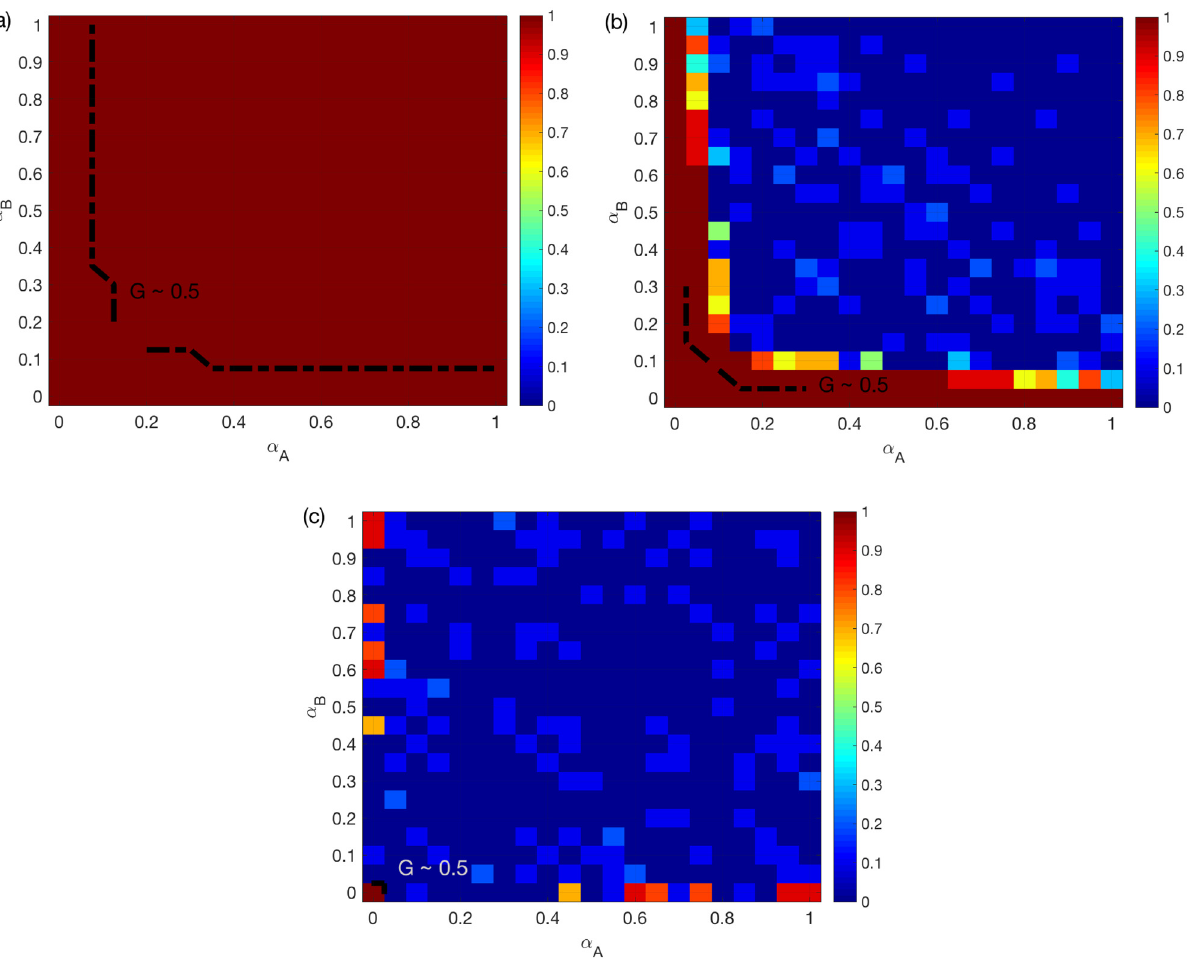
Fig 4. Best choice of overlap ratio r for two ER networks. (a) OR rule. (b) SUM rule. (c) AND rule. N = 500, k A = k B = 6, averaged over M = 90 realizations.The color for certain α A and α B values indicatesthe optimal r that leads to the largest mean G value. A dashedline is added to each sub-figure to indicate the location where the best mean G reaches